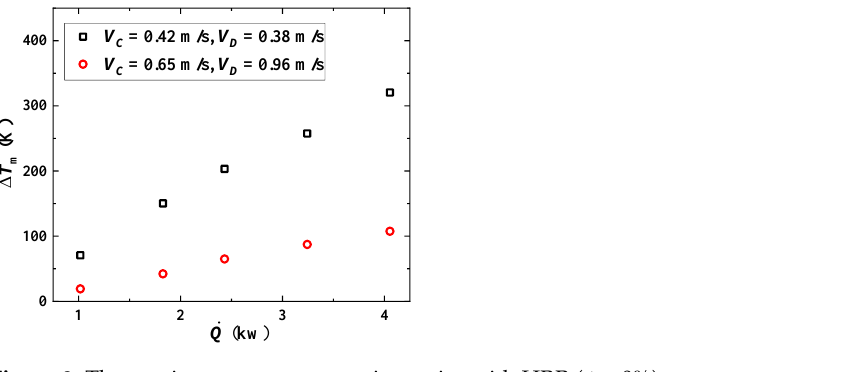
From Figures 6 – 8, with an increasing HRR, the maximum temperature rise increased. When the velocity increased for both ramps C and D, Q = 4.05 kW, the maximum tem- perature rise fell from 405 K to 107 K. The addition of HRR gradually reduced the increase in the maximum temperature rise.